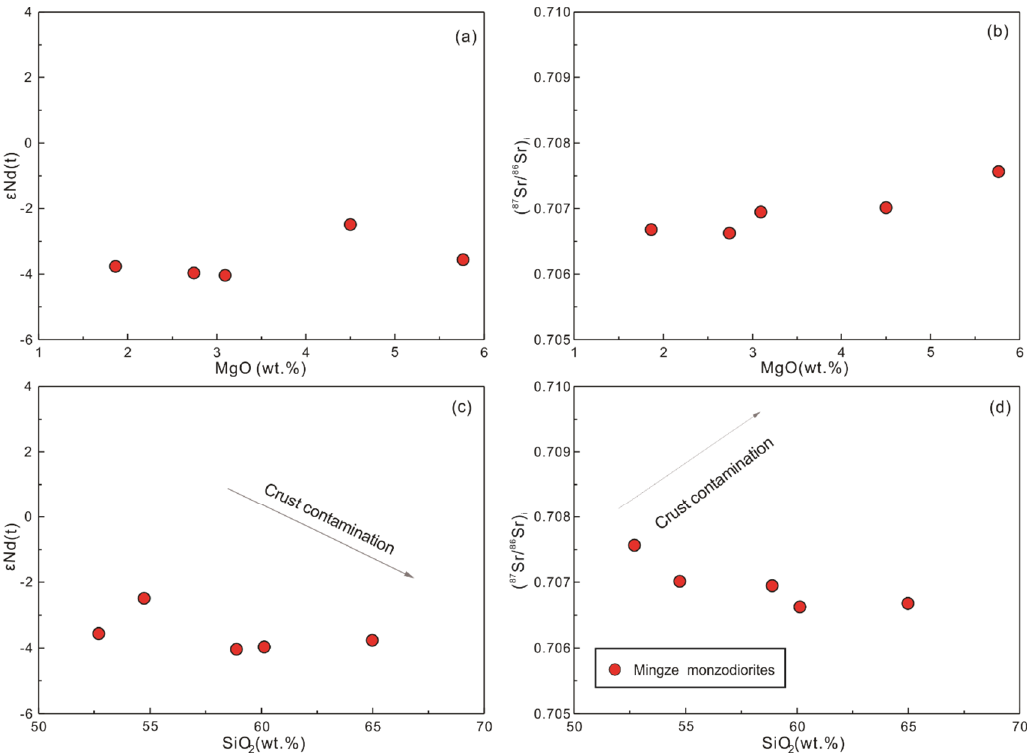
Figure 8. Plots of ( a ) ε Nd(t) versus MgO, ( b ) ( 87 Sr / 88 Sr) i versus MgO, ( c ) ε Nd(t) versus SiO 2 and ( d ) ( 87 Sr / 88 Sr) i versus SiO 2 .